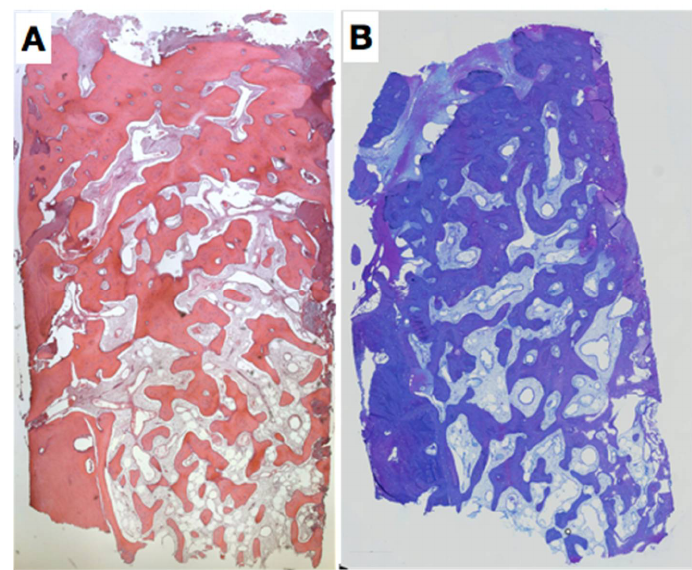
Figure 7. Paraffin ( A ) and acrylic resin ( B ) sections showing complete bone fill of the extraction socket 7 months after placement of a rigid, resorbable polymer membrane covering the missing buccal bone plate. The two histological sections show mature trabecular bone in the apical half with mature bone marrow, numerous blood vessels, and many embedded osteocytes, whereas mature compact bone prevails in the coronal-most region.